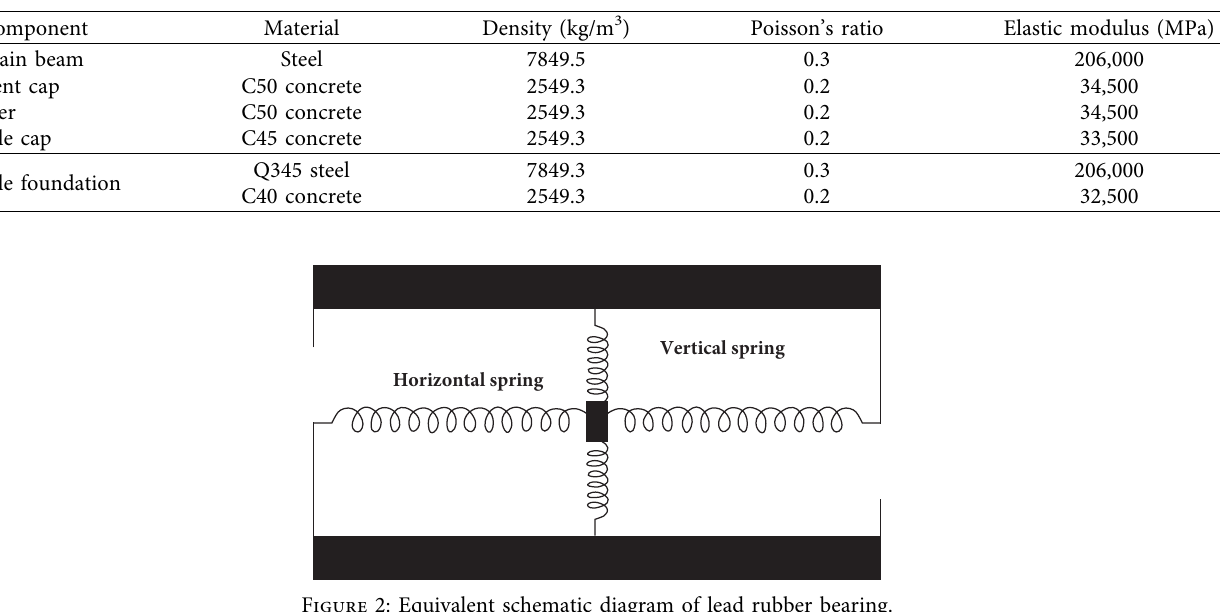
Figure 1: Diagram of nonnavigable continuous girder bridge of Hong Kong-Zhuhai-Macao Bridge. Table 1: Material parameters of components.